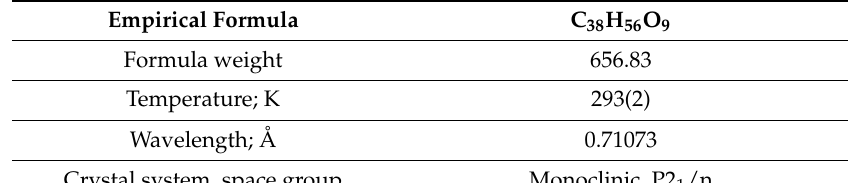
Table 8. Crystal data and structure refinement for